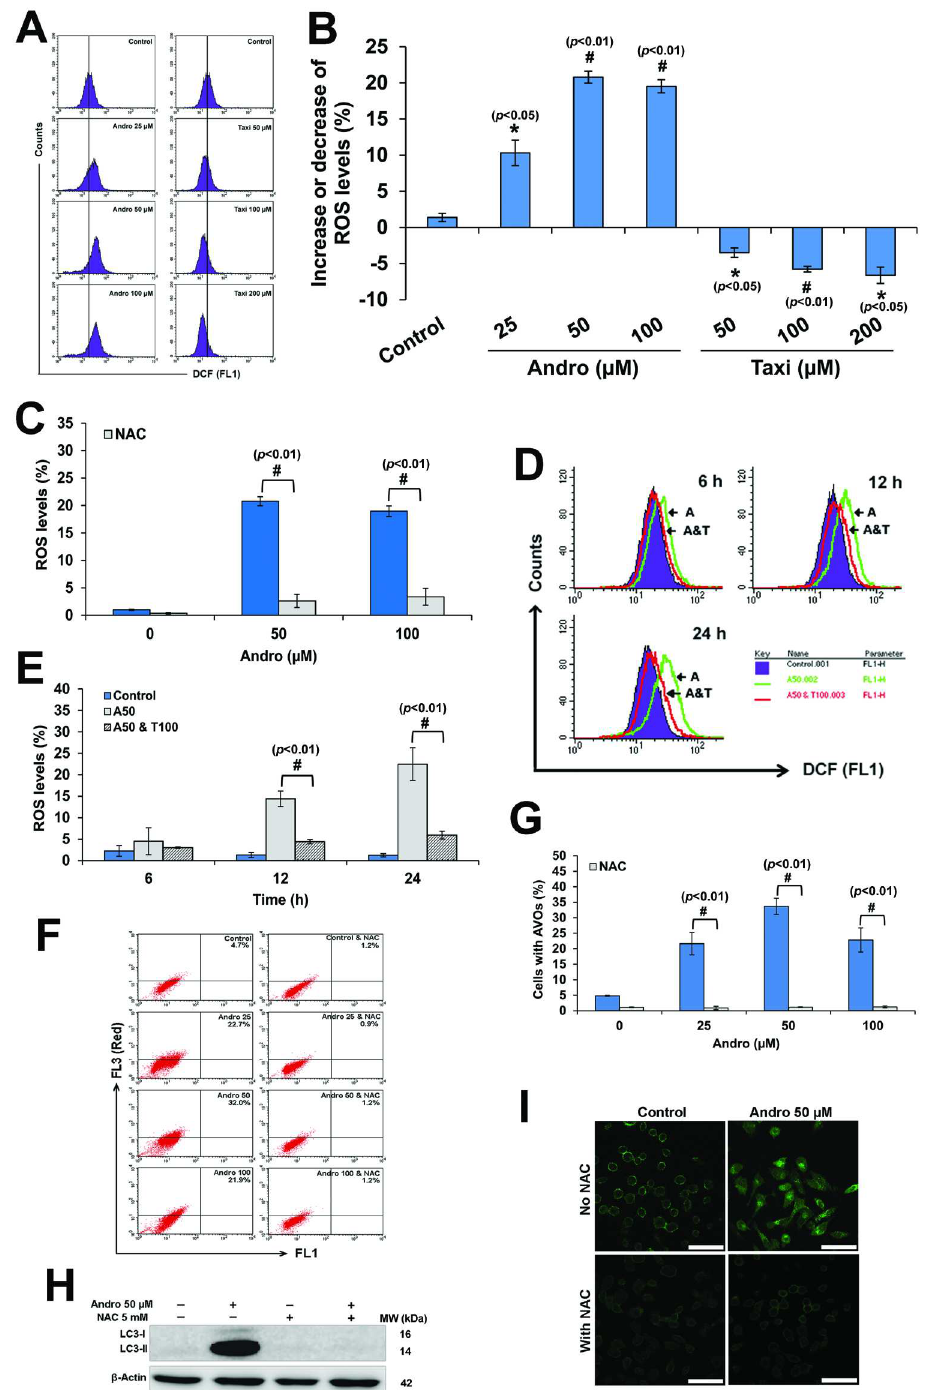
Fig 4. Andro induced ROS-dependent autophagy while Taxi attenuated it. Cells were treated as indicated, stainedwith DCF-DA and then analyzedusing the flow cytometer. (A) A representative histograms showingthe increasein ROS in HeLa cells treated with Andro (25, 50 or 100 μ M) while the decreasein ROS in those treated with Taxi (50, 100 or 200 μ M)for 24h. (B) The percentageof cells with higheror lower levels of ROS compared to the control in HeLa cells treated with different concentrations of Andro or Taxi for 24 h. (C) The percentageof ROS levels in cells treated with different concentrations of Andro with or without pretreatment with NAC. The cells were either pretreatedor not with NAC (5 mM) for 1 h, and then